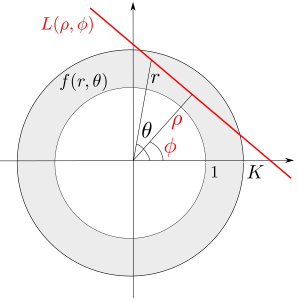
Figure 4. Computation of the Radon transform.